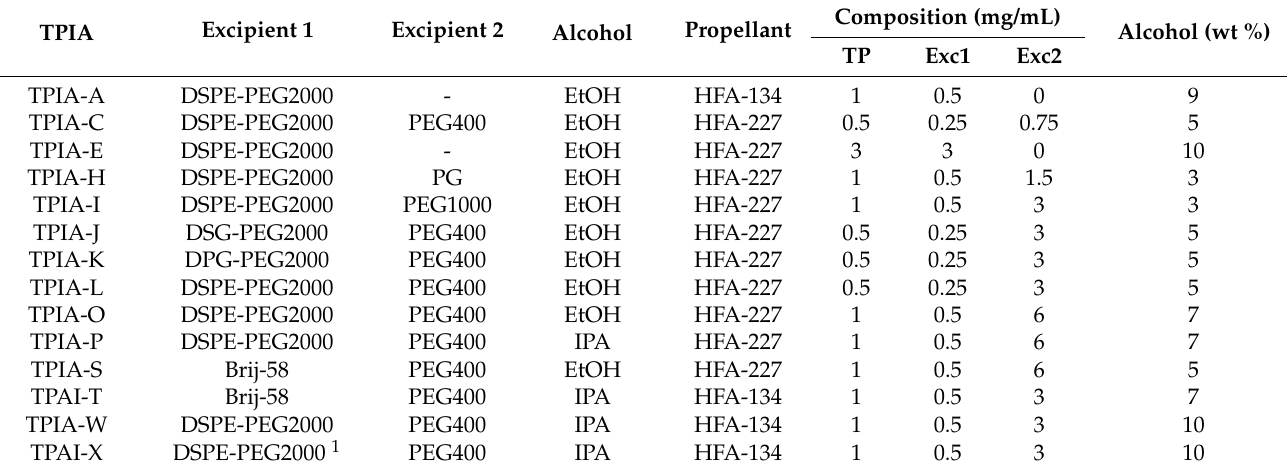
Table 1. Summary of the targeted compositions for selected metered-dose inhaler (MDI)